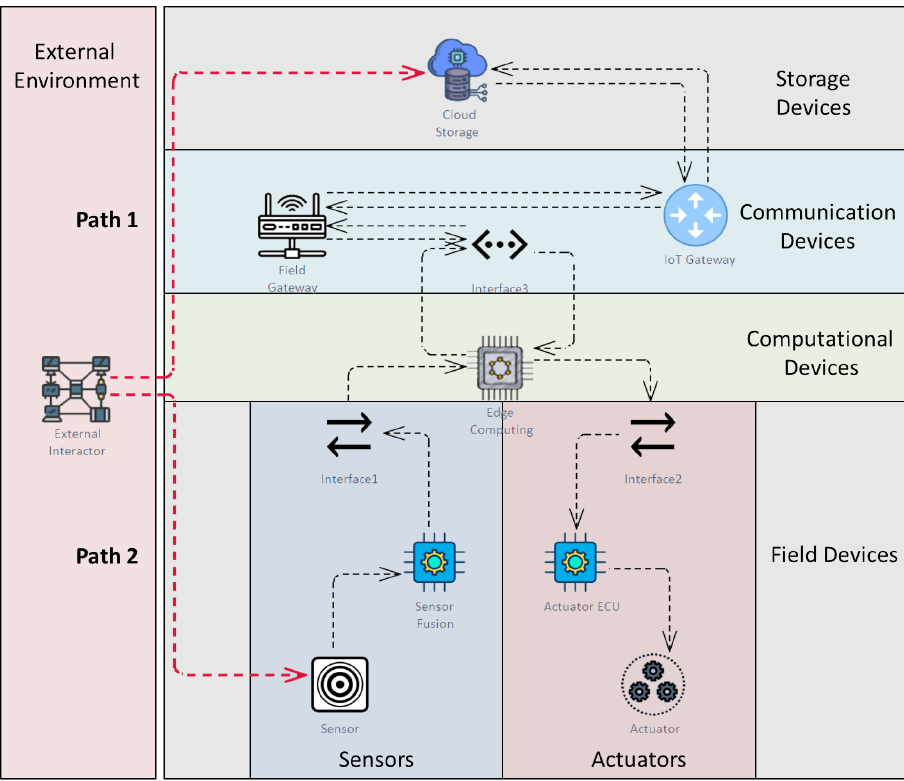
Figure 5. Modeling an agriculture example using ThreatGet.